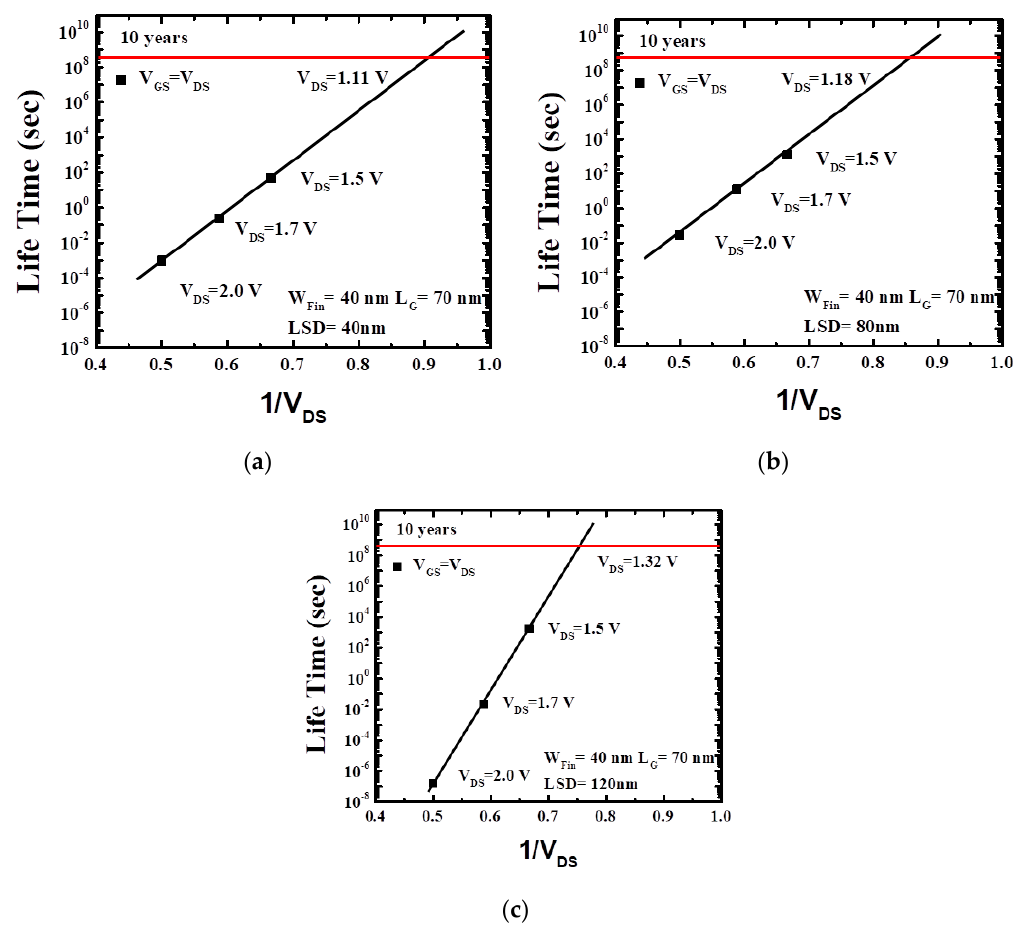
Figure 6. Device lifetime for different stress bias conditions with different spacer lengths under the stress conditions obtained by extrapolation with Figure 5 of: ( a ) LSD = 40 nm; ( b ) LSD = 80 nm; and ( c ) LSD = 120 nm.